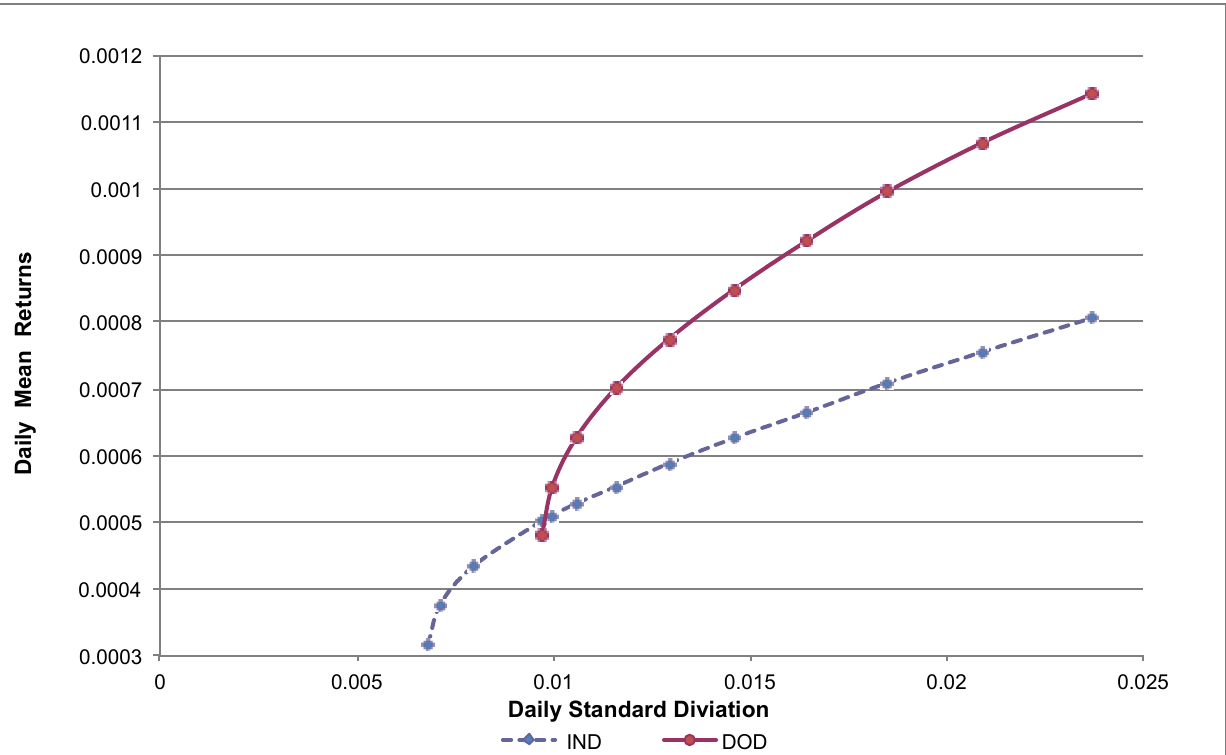
Figure 1. Mean-variance (MV) efficient frontiers of international and domestic diversification